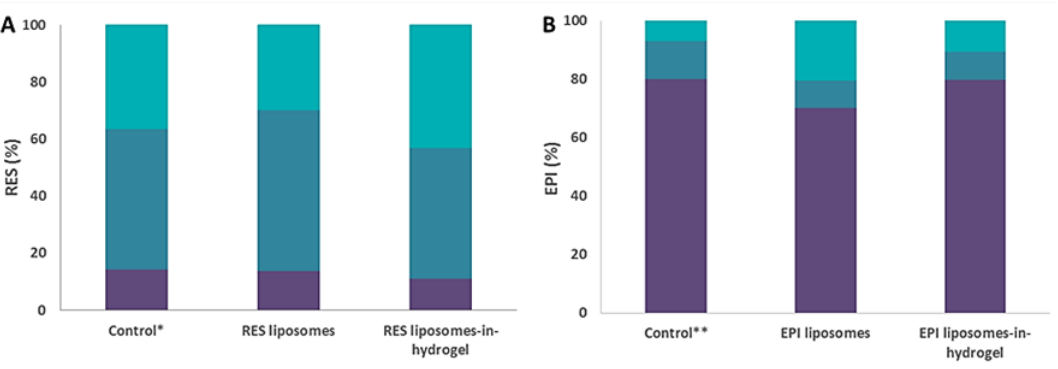
Figure 6. RES ( A ) and EPI ( B ) partitioning from liposomes and liposomes-in-hydrogel, after 8 h of ex vivo penetration experiment as compared to the respective controls. Results are expressed as percentage mean ( n = 3). * RES in propylene glycol. ** EPI in buffer.